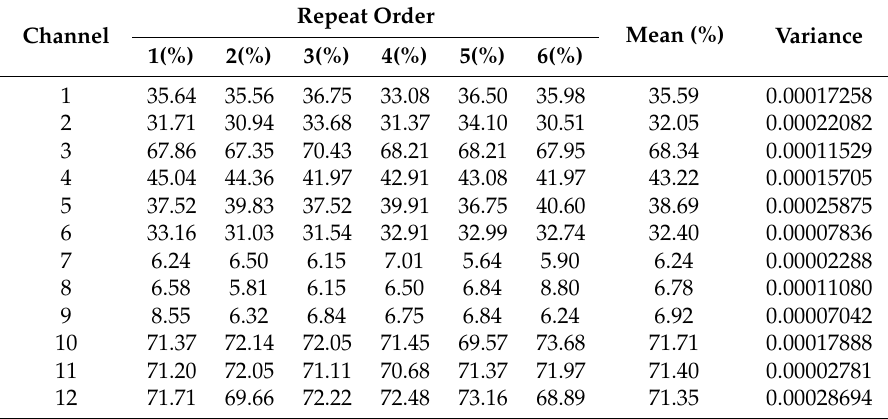
Table 3. Fault diagnosis results using LS-SVM model with one of the twelve channels data. Repeat Channel